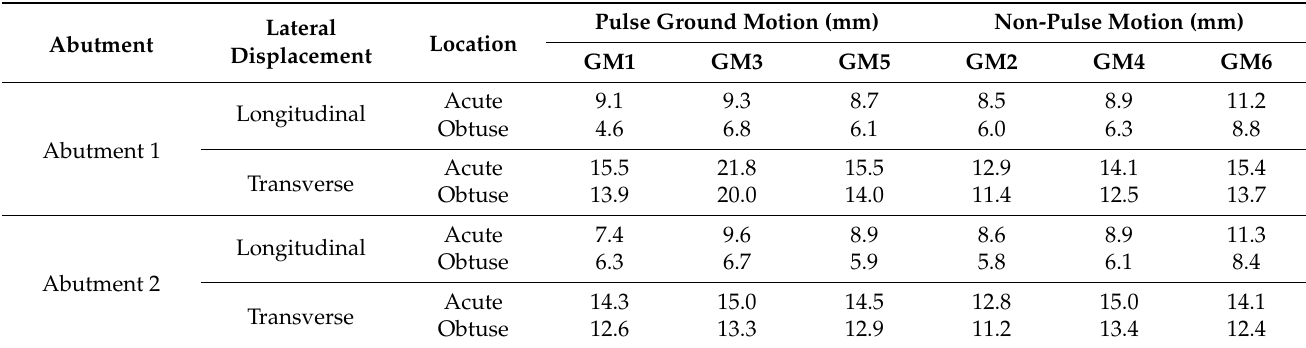
Table 4. Maximum abutment displacement for Model 10.